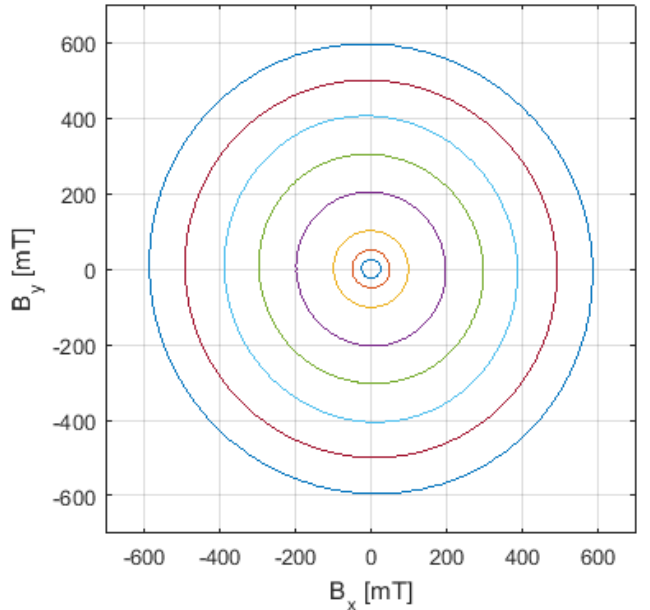
Figure 3. Circular trajectories of the magnetic induction vector measured for SET 1 utilized to train the NS.